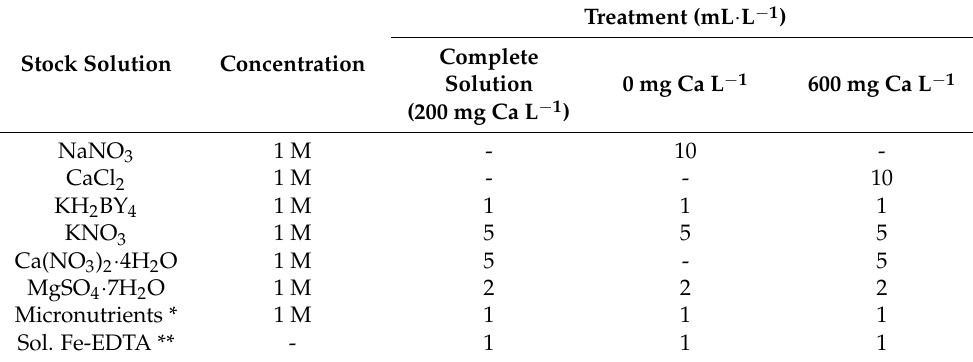
Table 1. Chemical composition of nutrient solution stocks, in mol · L − 1 , and treatments with Ca, in mL · L − 1 , were used in the experiment.